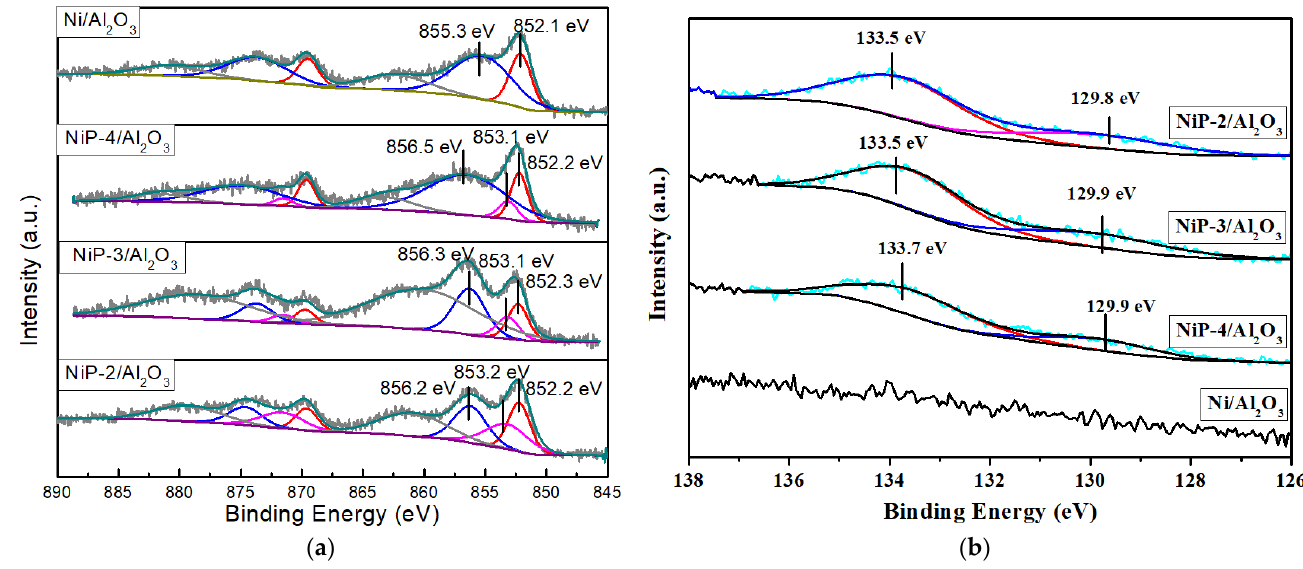
Figure 3. ( a ) Ni 2p and ( b ) P 2p XPS spectra of reduced Ni/Al 2 O 3 and NiP-x/Al 2 O 3 catalysts. Table 2. Ni species distribution (Ni X+ /Ni ratio) of reduced Ni/Al 2 O 3 and NiP-x/Al 2 O 3 catalysts. Nickel Species Catalyst